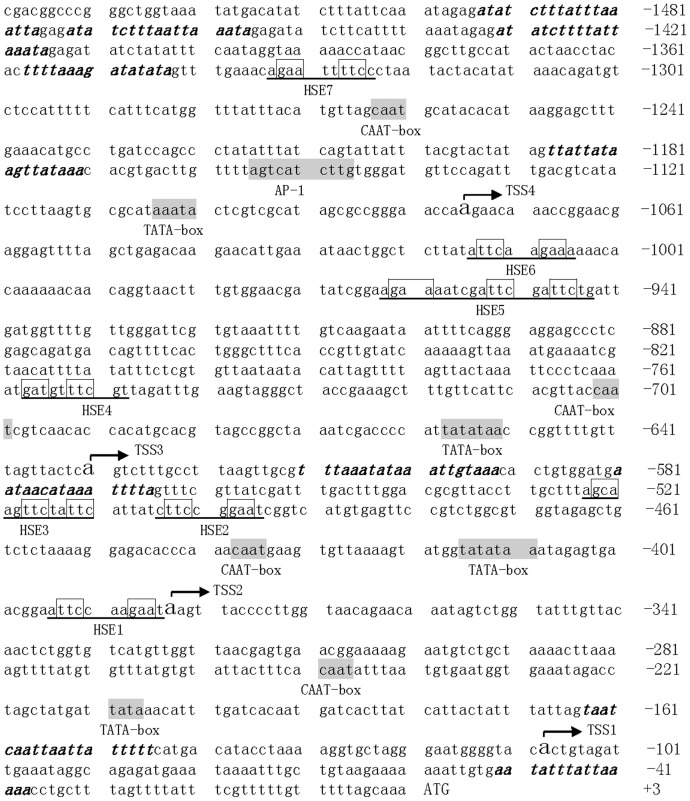
Sequence analysis of AiHSP70 promoter.The negative numbers on the right indicate upstream sequence relative to the translation start codon and the putative promoter elements are marked. The putative transcription start sites (TSS) are shown in bigger letters and curved arrow. The TATA box, CAAT box and one cis-element (AP-1) are shadowed by gray. The AT-rich regions are indicated by bold italic. The HSEs are indicated with underline and the core sequences (GAA/TTC) are boxed.